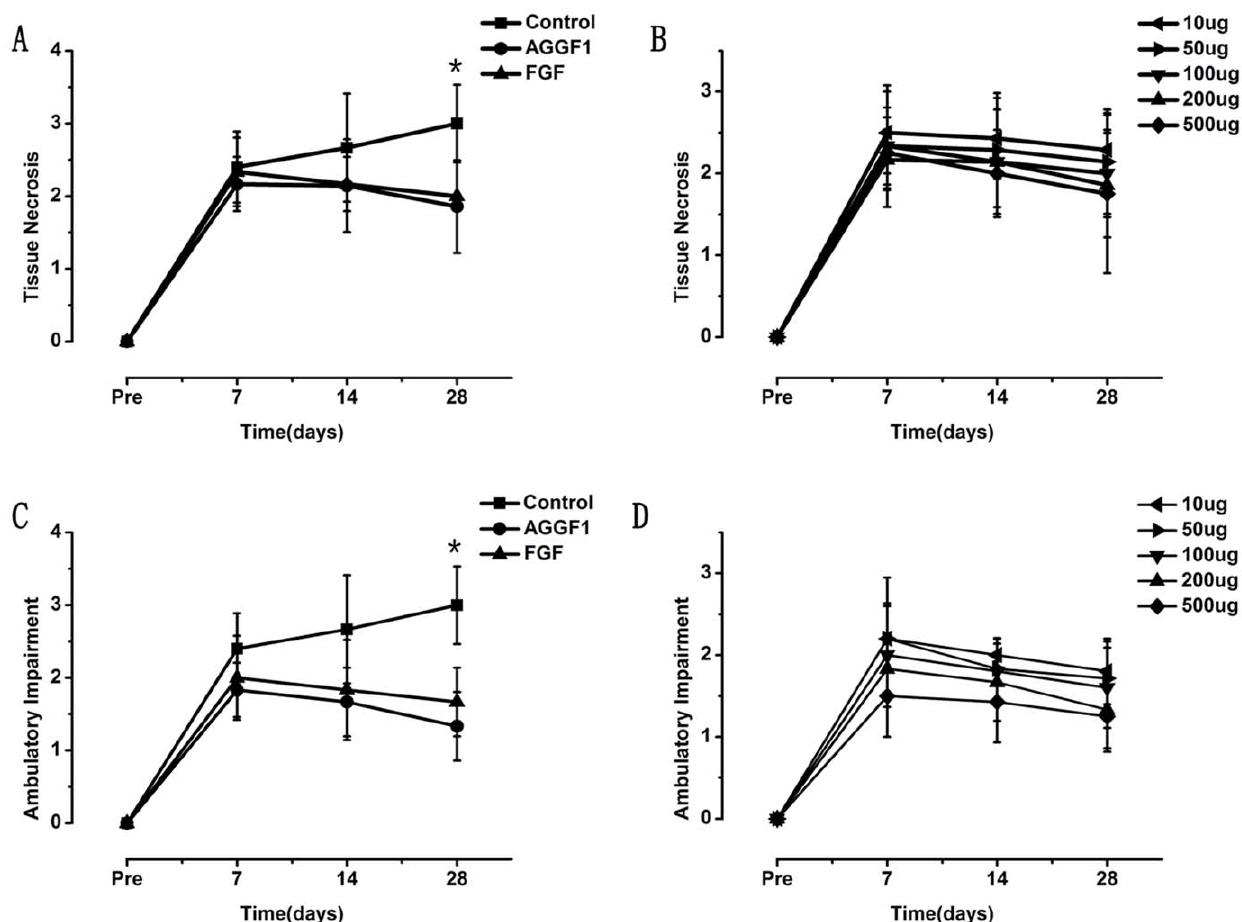
Figure 3. Effects of gene transfer for human AGGF1 by intramuscular administration of plasmid DNA on tissue necrosis and ambulatory impairment in a mouse ischemic hindlimb model. A ) Effect of overexpression of human AGGF1 on tissue necrosis. FGF-2 plasmid DNA was used as a positive control. Empty vector DNA was used as negative control (control). B ) Dose-response curve of tissue necrosis with varying amounts of AGGF1 plasmid DNA. C ) Effect of overexpression of human AGGF1 on ambulatory impairment. FGF-2 plasmid DNA was used as a positive control. Empty vector DNA was used as negative control (control). The scores of ambulatory impairment reflected the functional recovery of hindlimb ischemia after surgeries. D ) Dose-response curve of ambulatory impairment with varying amounts of AGGF1 plasmid DNA. Data are shown as mean 6 SEM (n=9 mice for each group). *, P , 0.05.